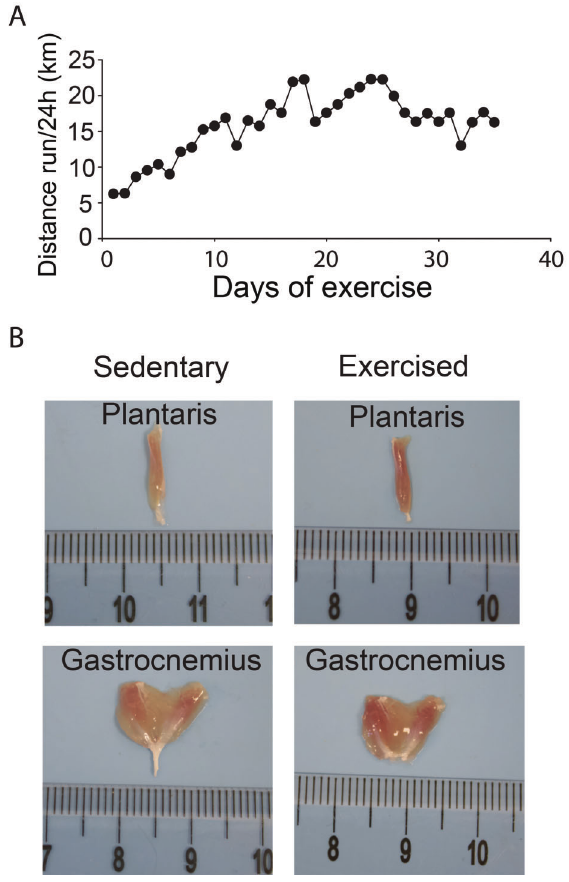
Figure 2. Total distance run per day, starting at B 10 weeks of age ( A ). Plantaris and gastrocnemius muscles from a sedentary mouse (left) and an exercised mouse, right ( B ). Note the darker reddish color of the muscles from the exercised mouse.